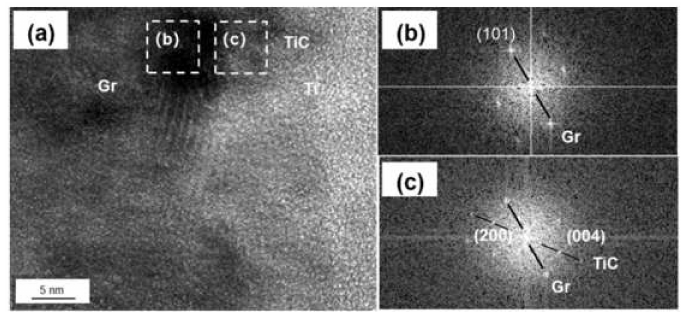
Figure 5. ( a ) HRTEM image of Ti-graphite surface; ( b , c ) FFT of ( a ).